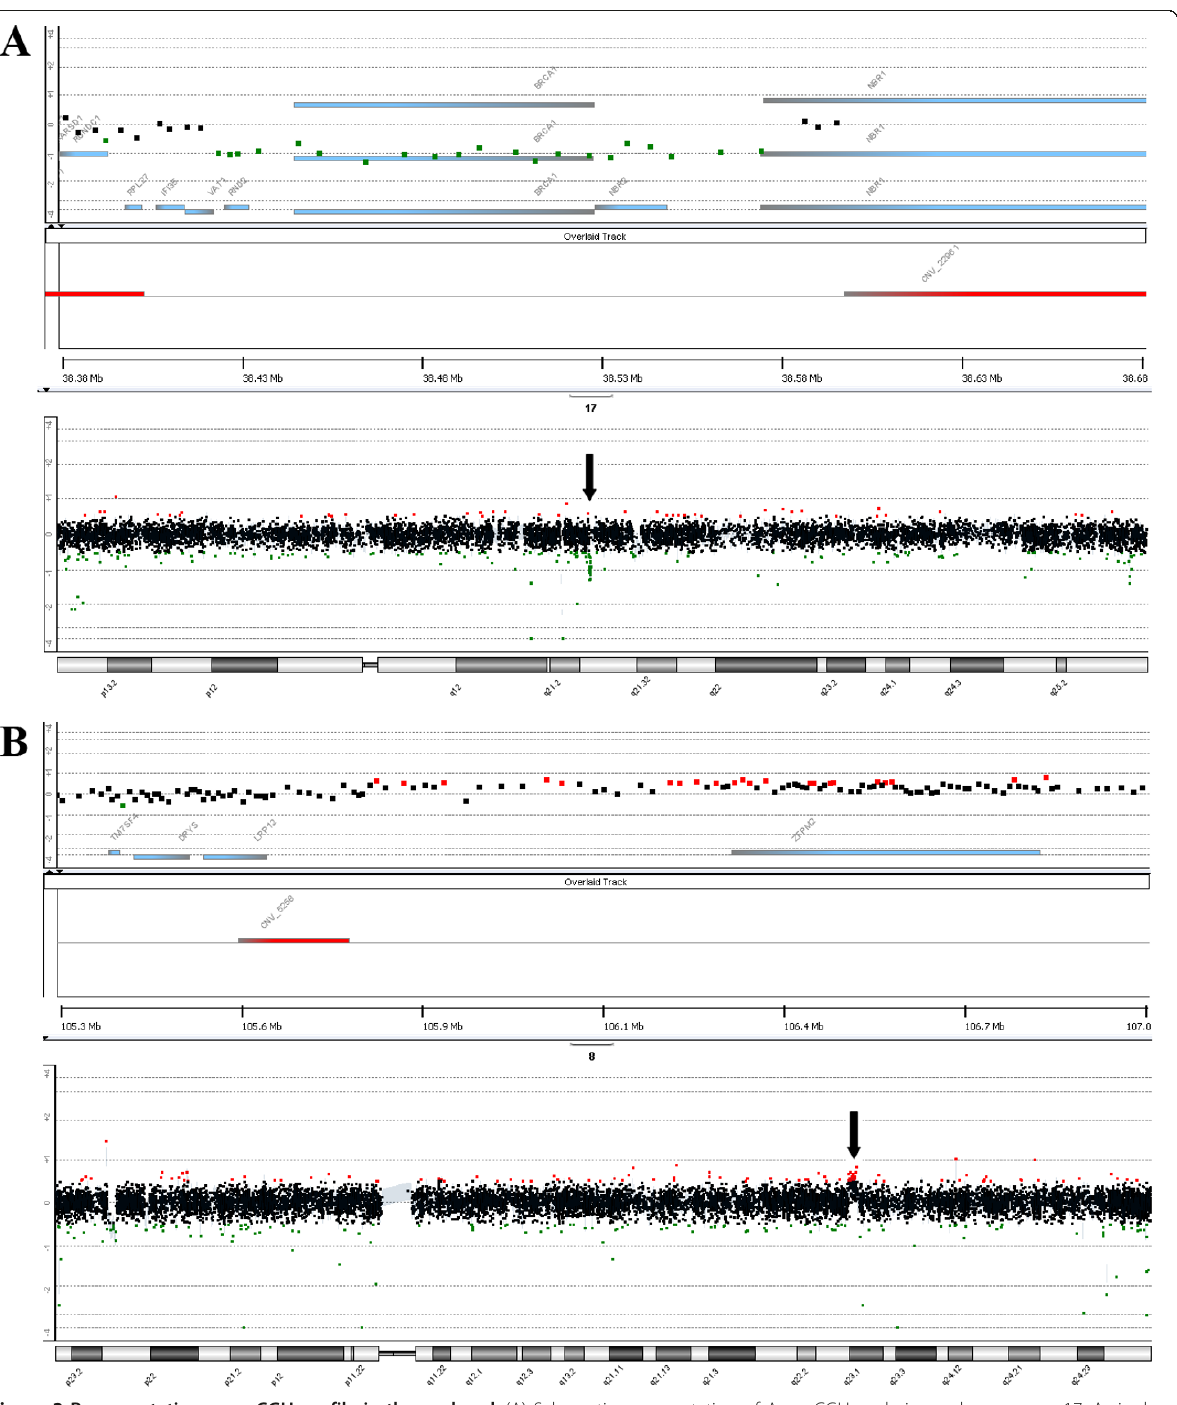
Figure 3 Representative array CGH profile in the proband . (A) Schematic representation of Array CGH analysis on chromosome 17. A single- copy deletion from the beginning of NBR1 to the VAT1 locus , including the RND2 , Ψ BRCA1 , BRCA1 and NBR2 complete genes is shown. (B) Schematic representation of Array CGH analysis on chromosome 8. A mosaicism for an amplification of the region corresponding to the ZFPM2 locus could be